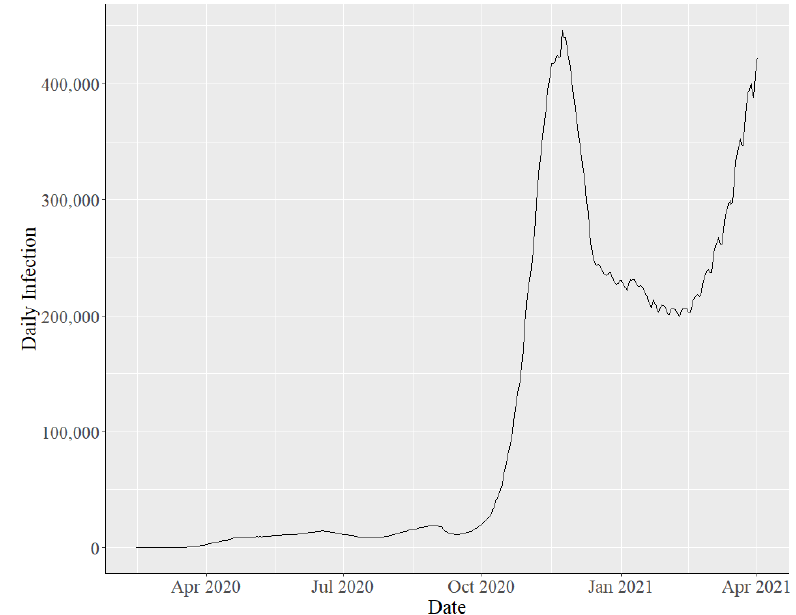
Figure 1. Daily cases of COVID-19 infection in Poland.